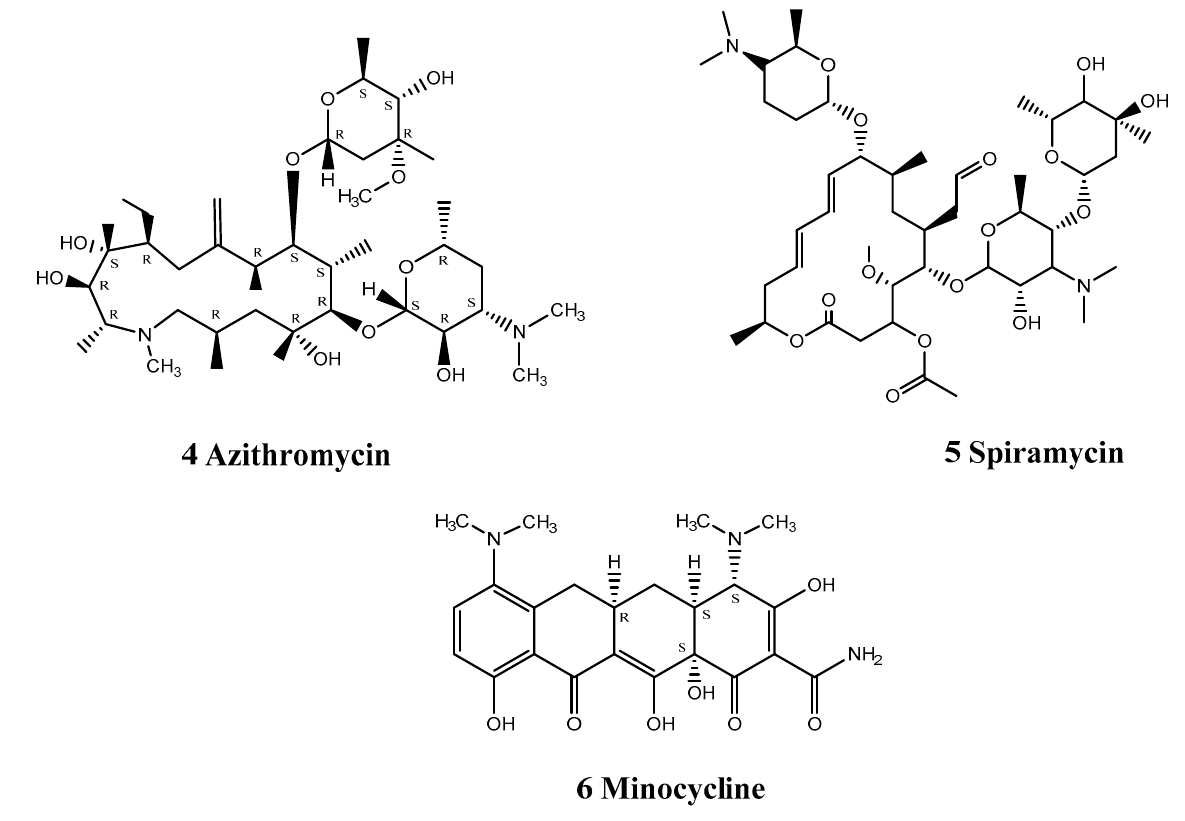
Figure 2. Structures of antibacterial drugs. Liao et al. found that the antibiotic minocycline (6) had anti-inflammatory and im- munomodulatory properties in infectious and inflammatory neurological disease models (Figure 2). They, therefore, carried out a series of in vitro and in vivo experiments to explore its effect on EV71 infection. Minocycline is a broad-spectrum antibacterial tetra- cycline antibiotic that can be combined with tRNA to achieve bacteriostatic effects and has the strongest antibacterial effect among tetracycline antibiotics. Unlike milrinone (drug 19), which is mainly used to treat complications of EV71 infection with no obvious anti-viral effect [63], minocycline reduced virus replication, specifically VP0 and VP2, while double-dose treatment suppressed cytokine production and viral protein expression in EV71-infected THP-1 cells